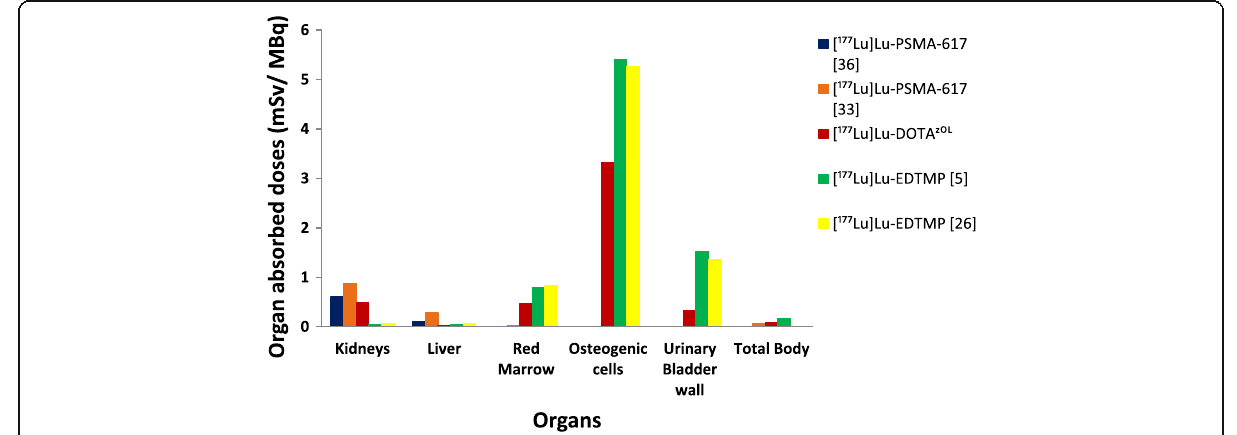
Fig. 5 Comparison of organ absorbed doses of [ 177 Lu]Lu-DOTA ZOL with [ 177 Lu]Lu-EDTMP [5, 26], [ 177 Lu]Lu-PSMA-617 [33,